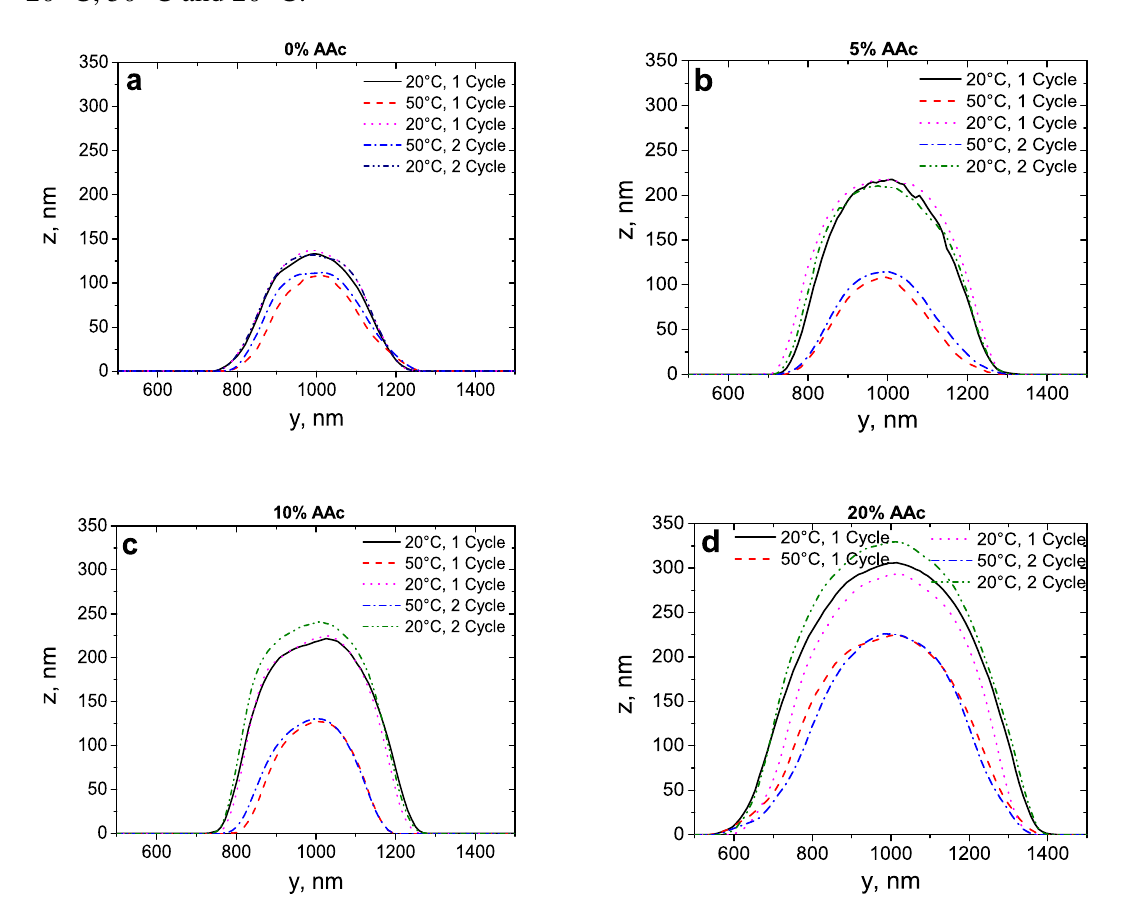
Figure 3. Cross sections of microgel particles with (a) 0%; (b) 5%; (c) 10%; and (d) 20% AAc contents adsorbed on gold wafer measured by SFM at two short cycles: 20 ◦ C, 50 ◦ C, 20 ◦ C, 50 ◦ C and 20 ◦